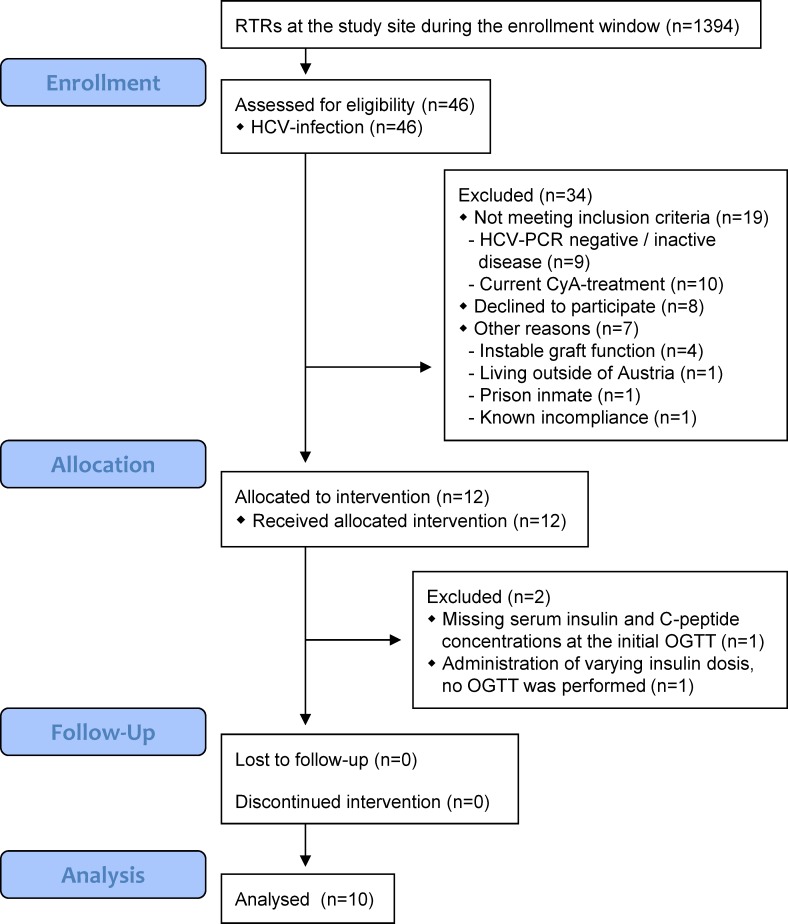
Trend flow chart.